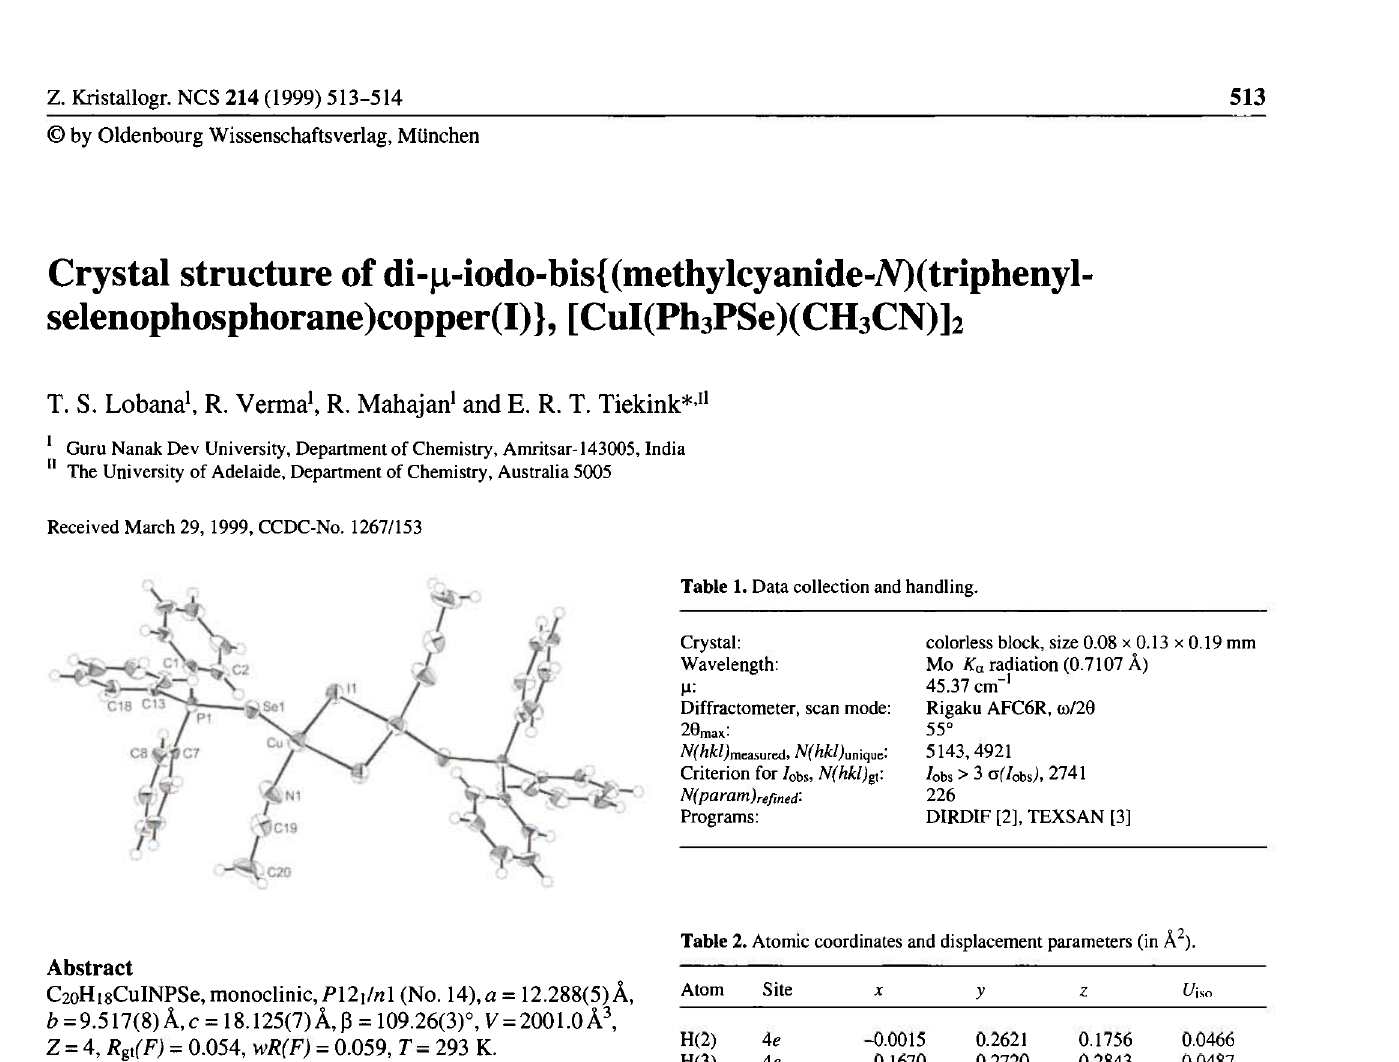
Table 2. Atomic coordinates and displacement parameters (in Ä 2